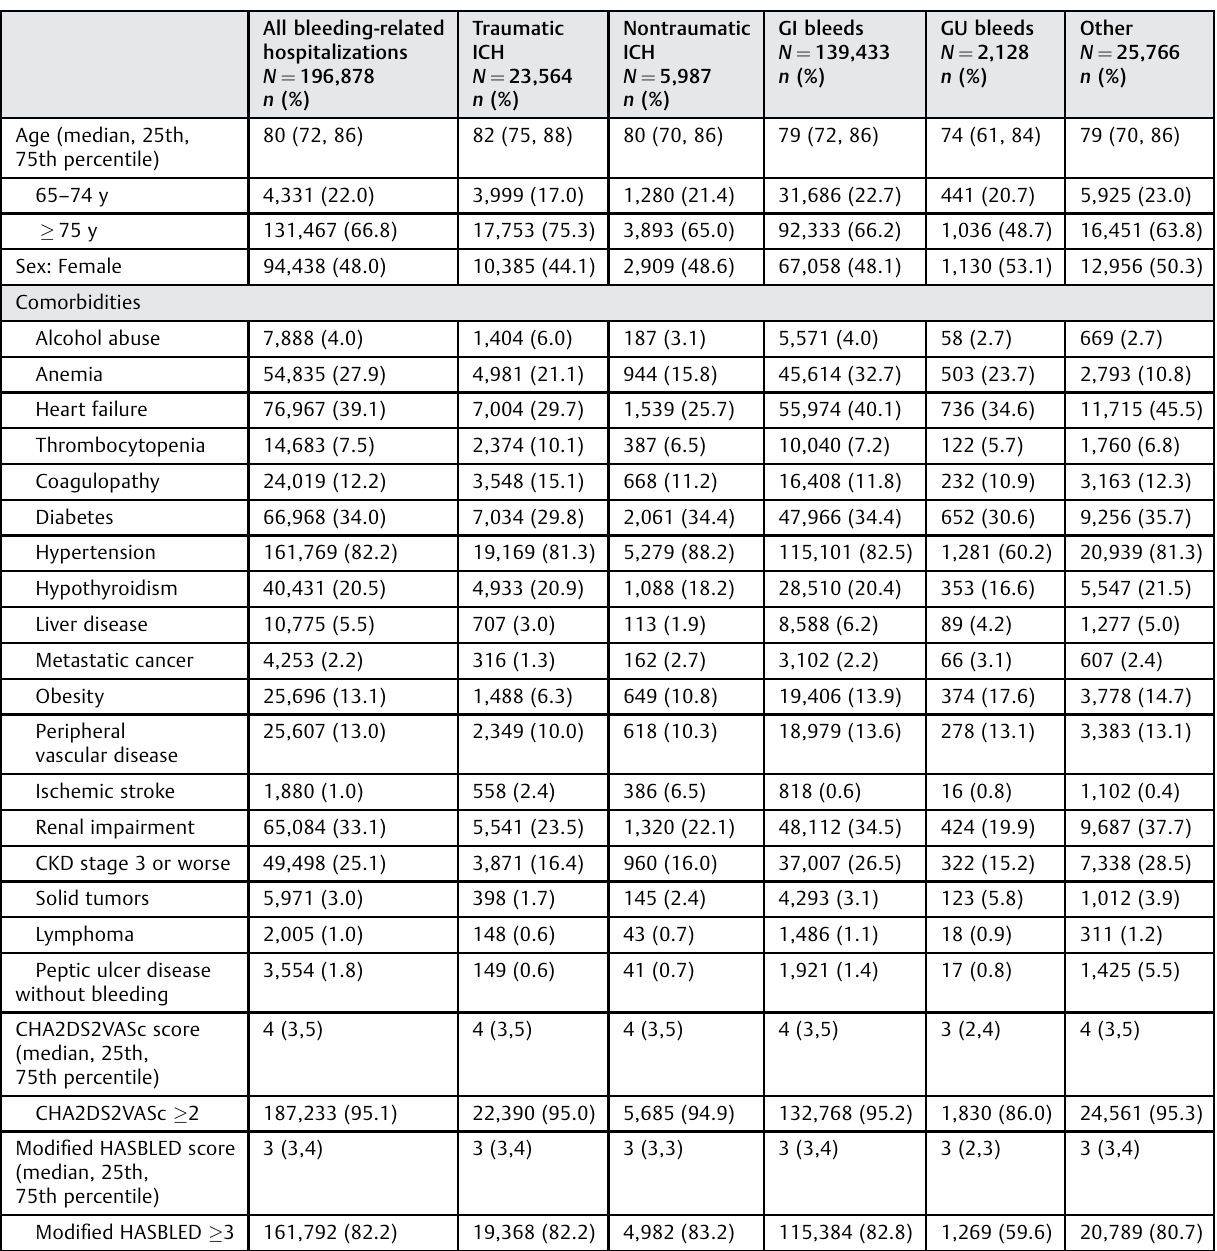
Table 1 Baseline